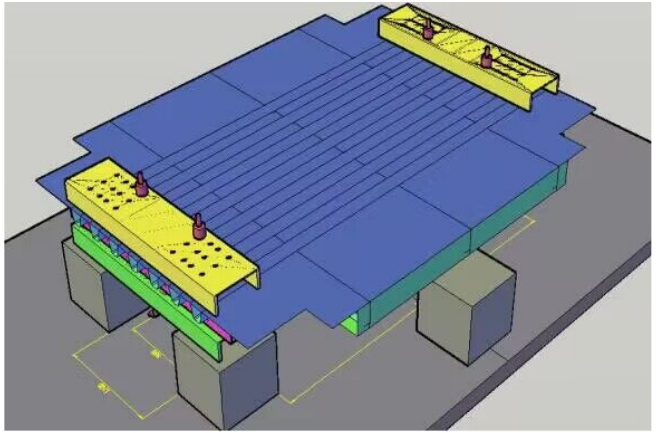
Figure 4. The model of OSD segmental deck.